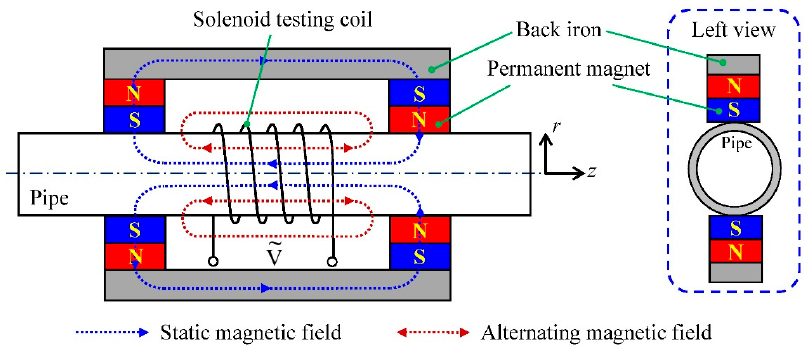
Figure 1. The conventional configuration of EMAT for longitudinal guided wave testing.